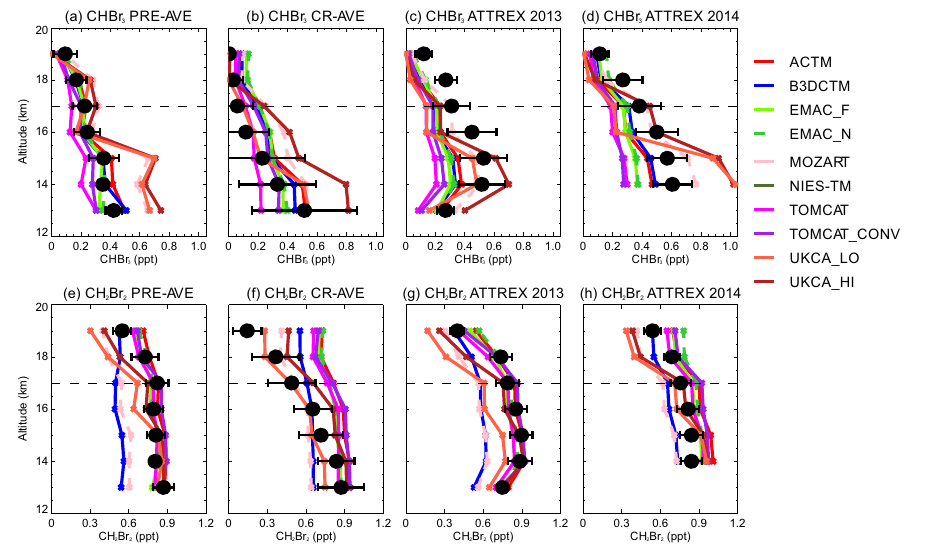
Figure 11. Comparison of modelled vs. observed volume mixing ratio (ppt) of CHBr 3 (a – d) and CH 2 Br 2 (e – h) from aircraft campaigns in the tropics (see main text for campaign details). The observed values (filled circles) are averages in 1km altitude bins and the error bars denote ± 1 σ . The dashed line denotes the approximate cold point tropopause for